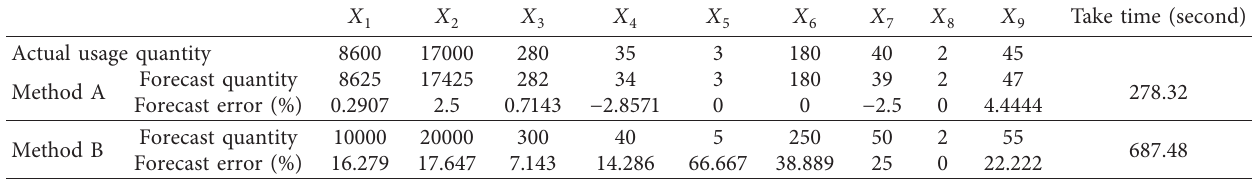
Table 6: Predicted value of method A and method B, as well as actual usage in target